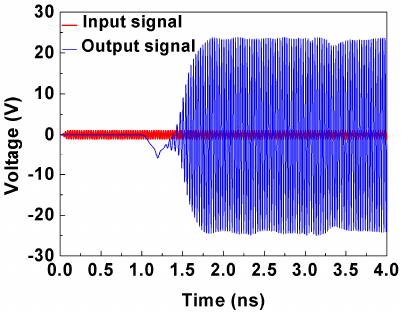
Figure 7. Input and output signals plot of the novel amplifier at 35 GHz.